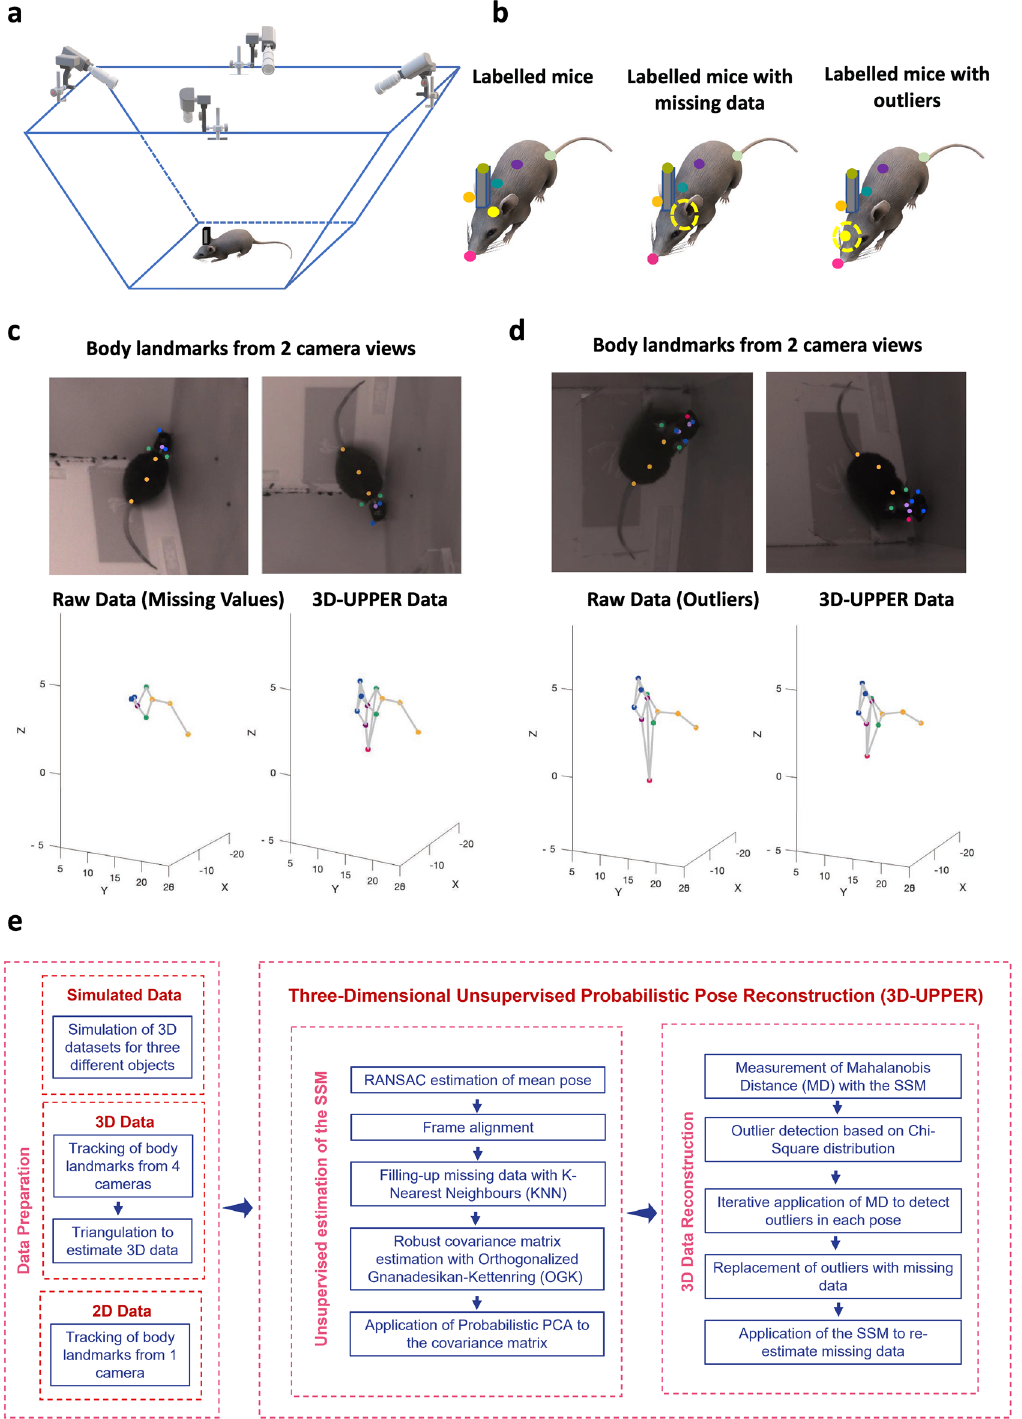
Figure 1. ( a ) A schematic of the behavioural arena, with four cameras positioned above the arena. ( b ) Drawings of a correctly labelled animal (left), of an animal missing labelling on the left ear (middle) and of an animal in which left ear labelling has been erroneously located on the snout (right). ( c ) Automatic labelling of freely moving animals (top), “raw” 3D data after triangulation (bottom left) and recovered 3D reconstruction with 3D-UPPER (bottom right). Since some labels are missing from automatic labelling, the raw 3D reconstruction is contaminated by missing data. The 3D-UPPER algorithm is able to re-estimate the missing data. ( d ) Same as panel c but here the nose label is incorrectly located introducing an outlier in the 3D reconstruction. The 3D-UPPER algorithm can detect the outlier and re-estimate its position. ( e ) Flow chart of data preparation and the 3D-UPPER